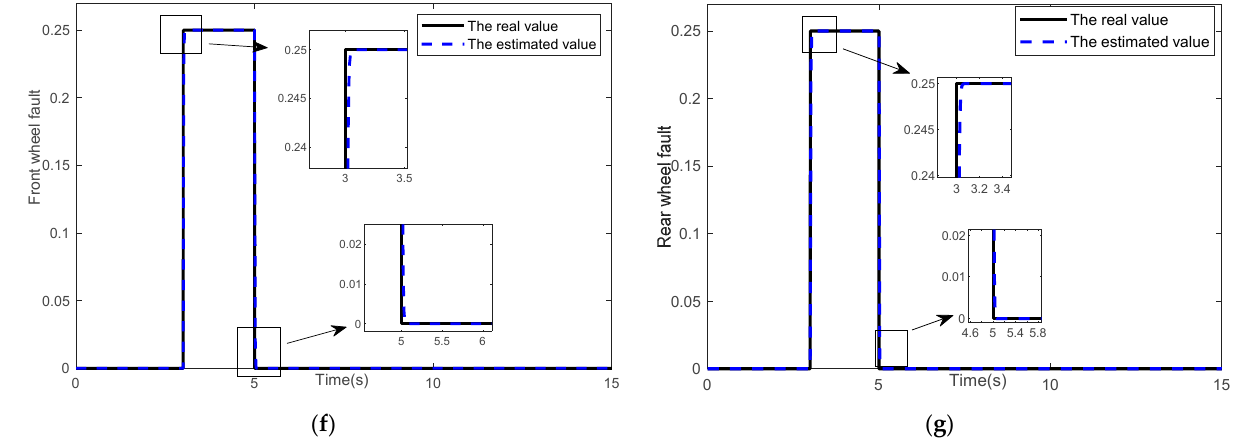
Figure 4. The response curve of the system. ( a ) The curve of front and rear wheel angle. ( b ) The curve of the yaw rate. ( c ) The curve of side slip angle. ( d ) The error curve of the yaw rate. ( e ) The error curve of side slip angle. ( f ) The curve of front wheel fault. ( g ) The curve of rear wheel fault. In view of the harsh environment on wet roads, the input curves of front and rear wheel angles are shown in Figure 4a. Figure 4b,c shows the curves of the yaw rate and side slip angle of the vehicle. The state estimation error curves are given in Figure 4d,e.